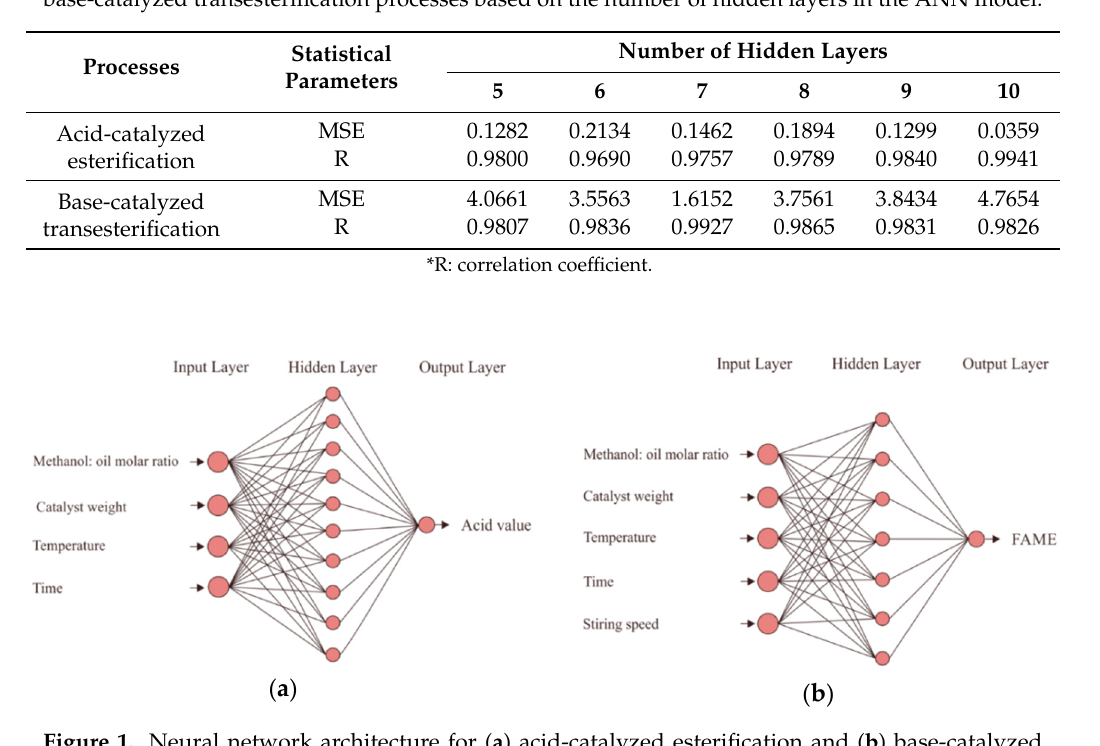
Table 6. Correlation coefficients and mean squared errors for the acid-catalyzed esterification and base-catalyzed transesterification processes based on the number of hidden layers in the ANN model.